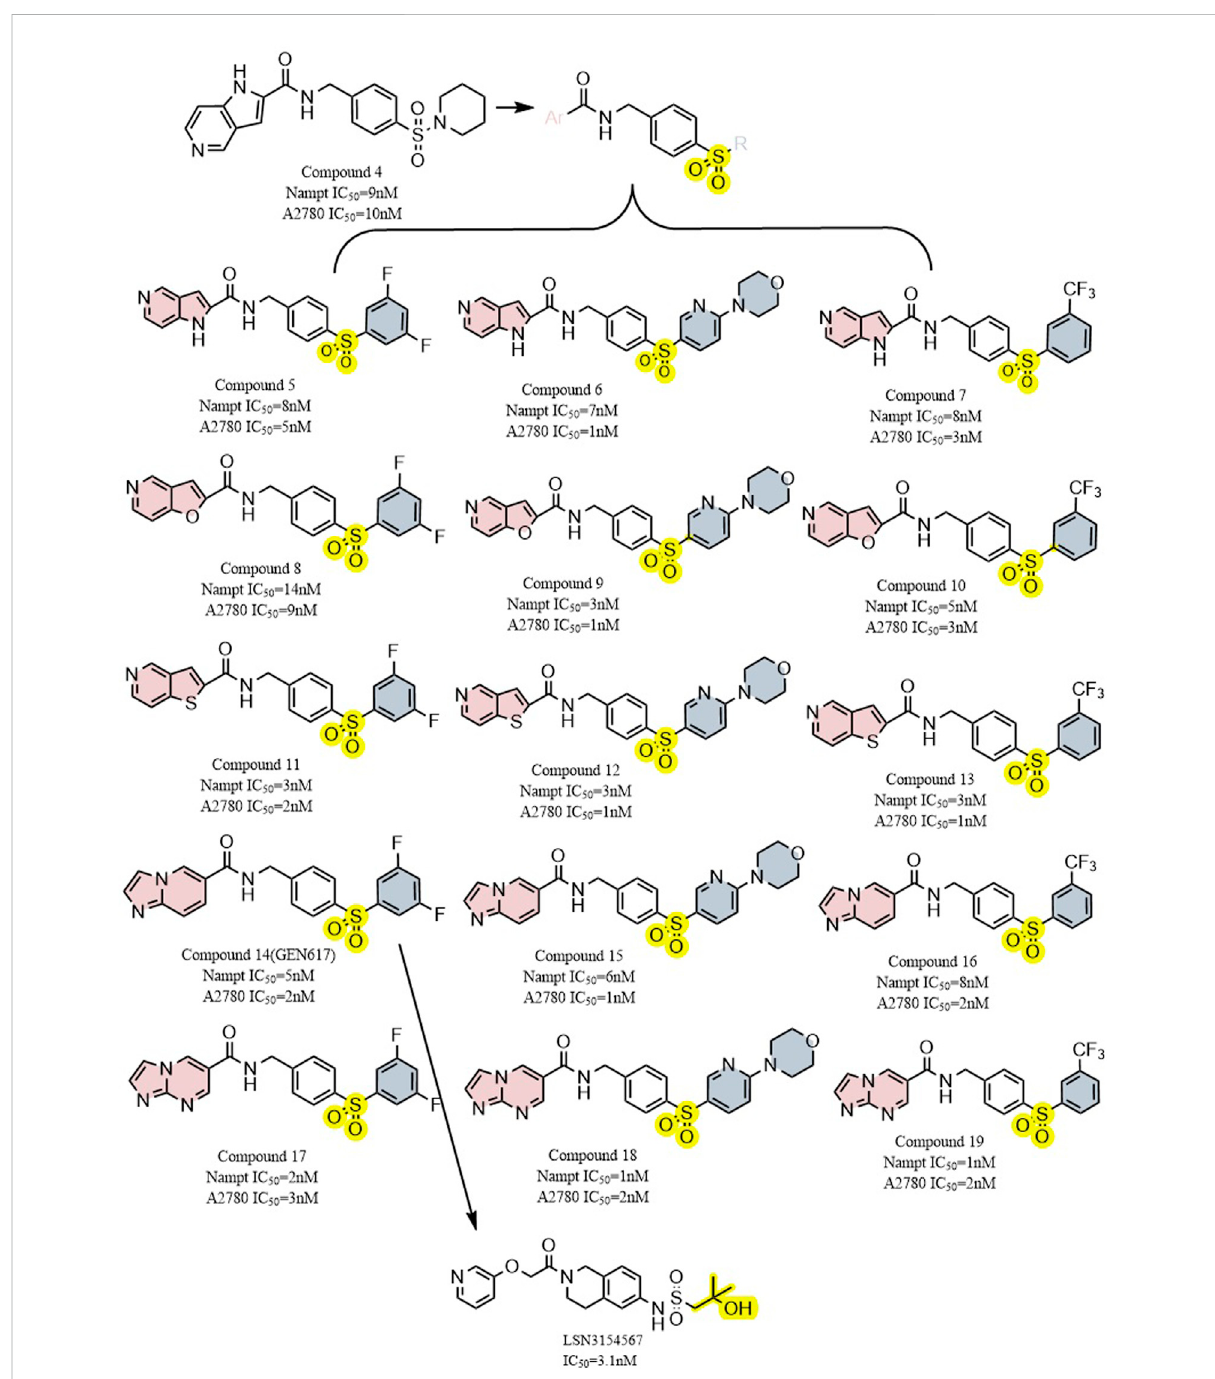
FIGURE 6 Structural modi fi cation of sulfur-containing NAMPT inhibitors and the typical compound GEN617,LSN3154567.